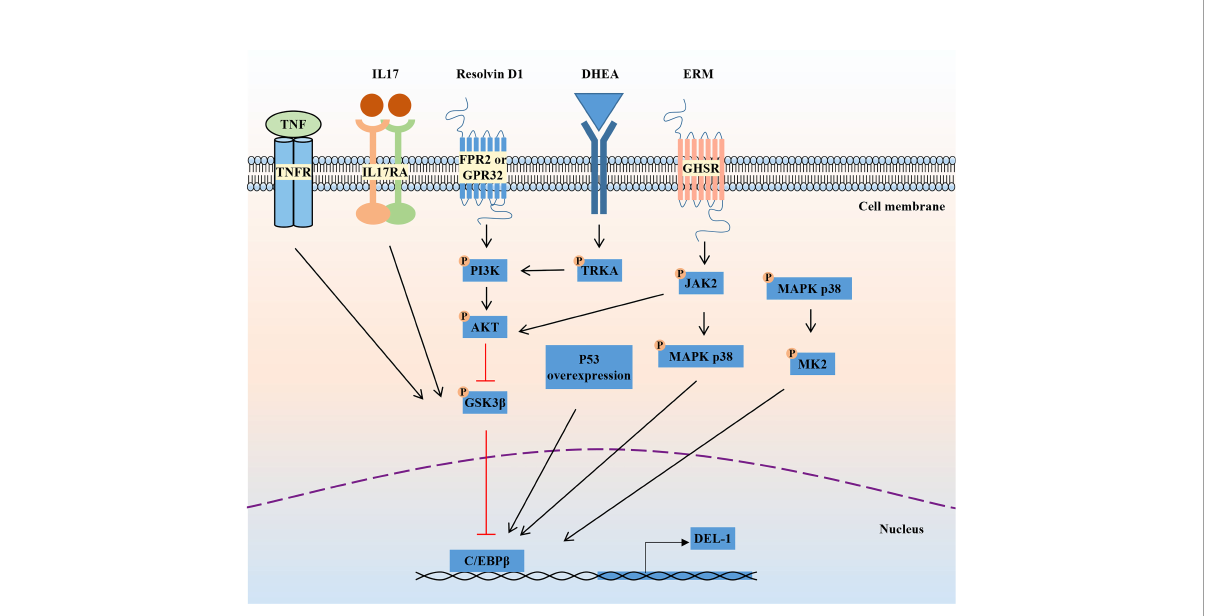
FIGURE 1 Regulation of DEL-1 expression. IL-17 and TNF reduce DEL-1 expression in a GSK3 b -dependent process that inhibits the binding of the key transcription factor C/EBP b to the EDIL3 promoter, thereby downregulating EDIL3 transcription. This inhibitory action of IL-17 can be reversed at the GSK-3 b level by PI3K/AKT signaling induced by D-resolvins. Through interaction with GHSR, ERM activates JAK2 signaling, leading to DEL-1 transcription, which is MAPK p38-mediated and C/EBP b dependent, as well as to PI3K/AKT-mediated reversal of the GSK3 b -dependent inhibitory effect of IL-17 on DEL-1 expression. DHEA reduced DEL-1 expression and secretion in endothelial cells by activating TRKA and downstream PI3K/AKT signaling to restore C/EBP b binding to the DEL-1 promoter. In addition, P53 overexpression and the activation of P38/ MK2 signaling were reported to promote DEL-1 expression. DEL-1, developmental endothelial locus-1; GSK-3 b , glycogen synthase kinase 3 b ; C/ EBP b , CCAAT/enhancer-binding protein b ; PI3K, phosphoinositide 3-kinase; MAPK, mitogen-activated protein kinases; GHSR, growth hormone secretagogue receptor; ERM, erythromycin; JAK2, janus kinase 2; DHEA, dehydroepiandrosterone; TRKA, tropomyosin receptor kinase